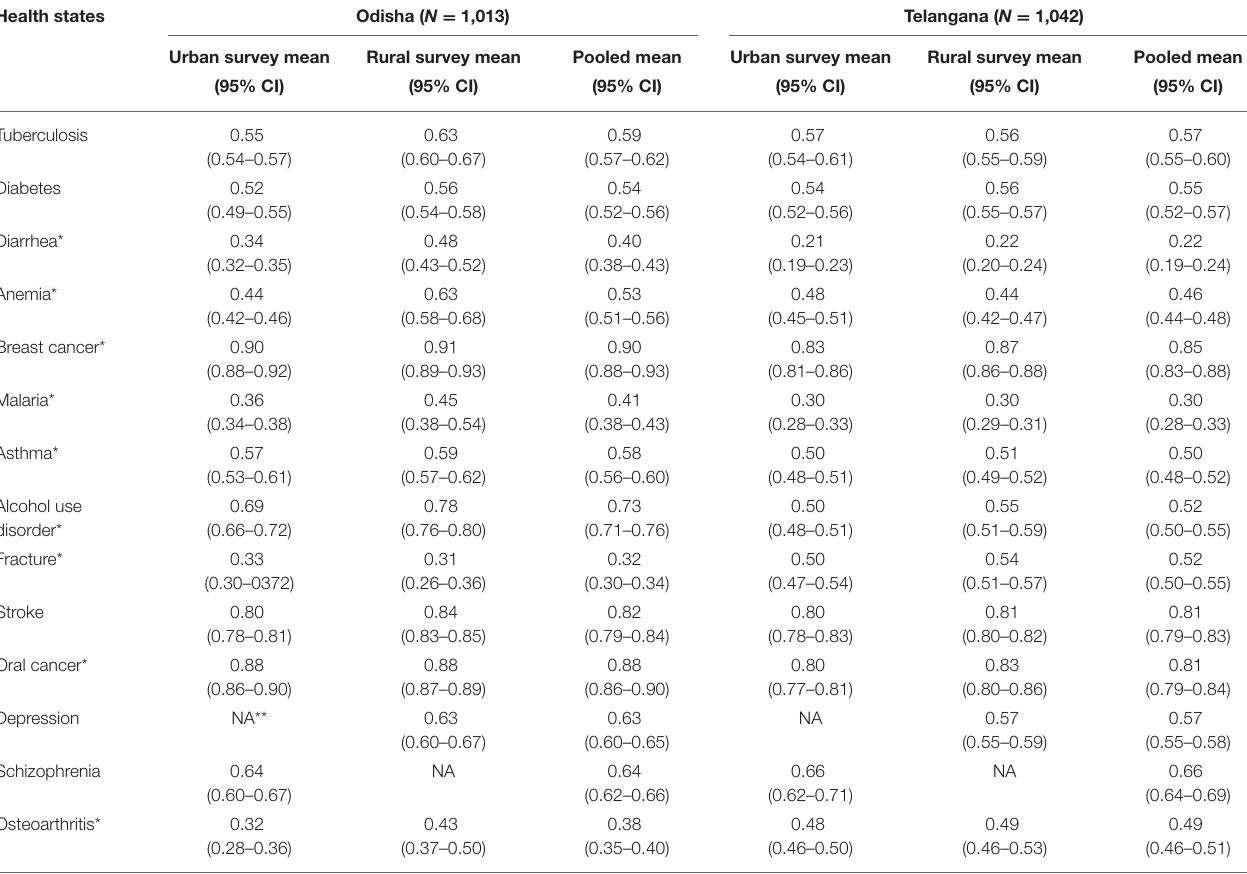
TABLE 3A | State-wise survey mean disability weights across urban and rural